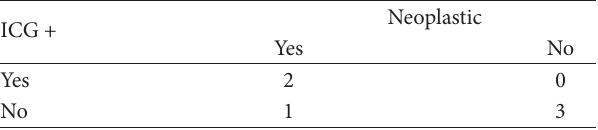
Table 2: Evaluation of ICG uptake as a biomarker for polyp classification. A TBR > 1.2 as the cutoff value for neoplasia was